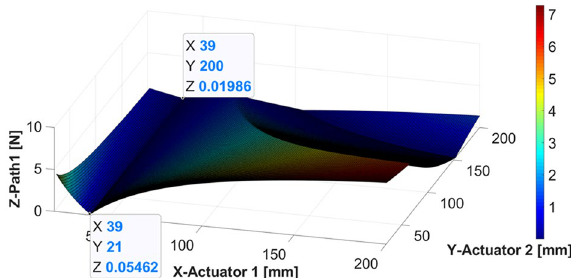
Figure 13. Control force of actuator 1 when the shaker is placed at 40 mm ( generated with MATLAB R2018b, https:// mathw orks. com).